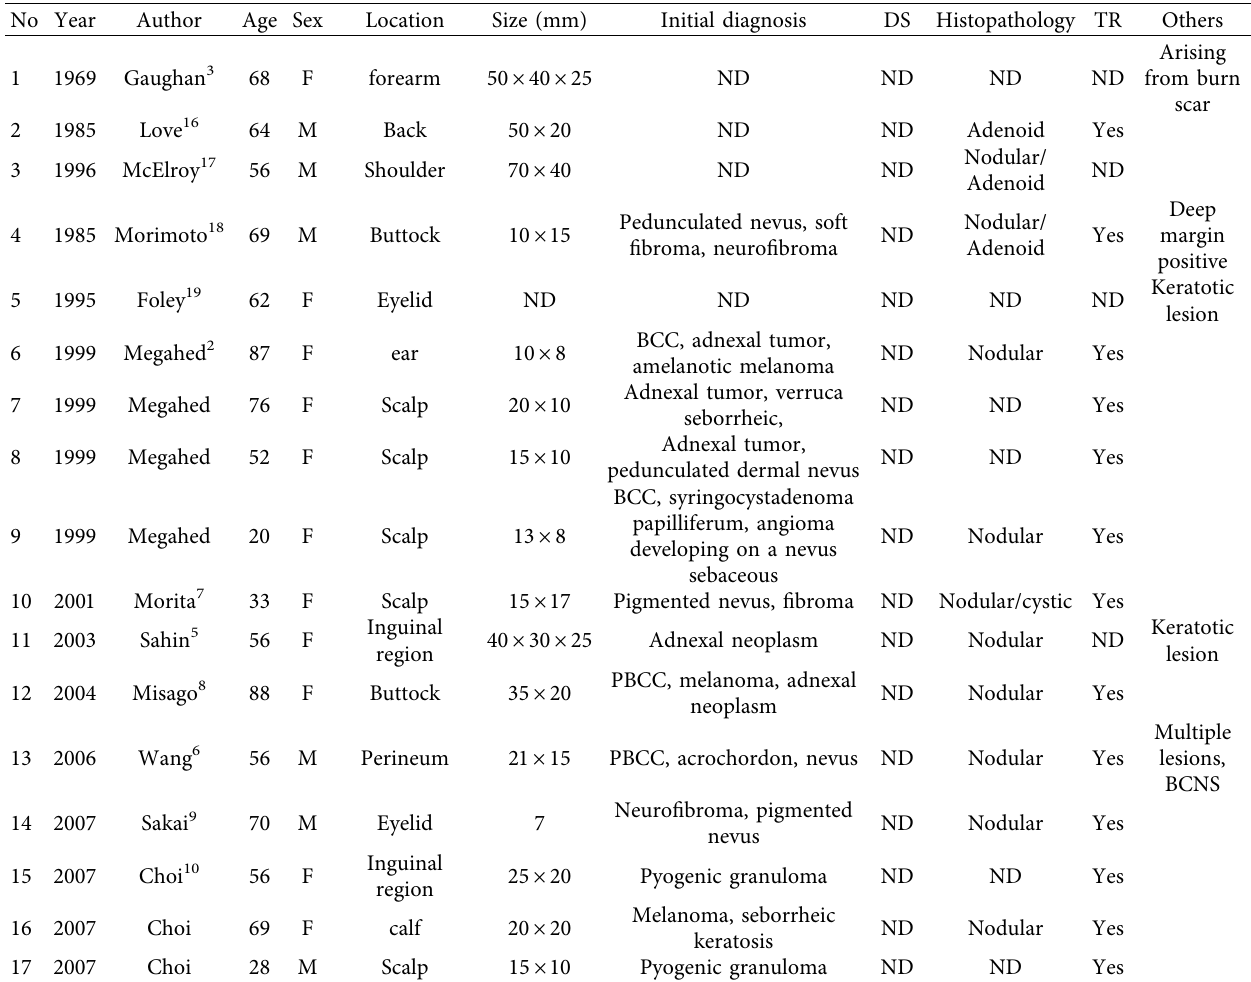
Figure 1: Clinical manifestation and histopathology. (a) A polypoid nodule was seen on the nose tip. (b) The lateral view shows a stalk on the nose. (c) Dermoscopy shows arborizing vessels and pigmented ovoid nests. (d) A low-power view showed basophilic nests in the dermis (hematoxylin and eosin staining, × 20). (e) A high-power view of the upper square showed basaloid cells with palisading (hematoxylin and eosin staining, × 200). (f) A high-power view of the lower square showed cystic spaces (hematoxylin and eosin staining, × 200). (g) Immunostaining with Ber-EP4 is more strongly positive in shallow lesions. Table 1: Clinical and pathological summary of